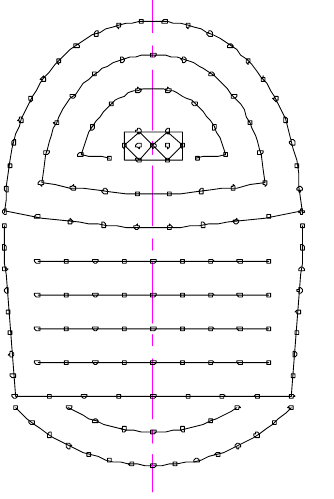
Figure 2. Blast hole layout.